Question: Compose a caption that would accompany this figure in a paper.
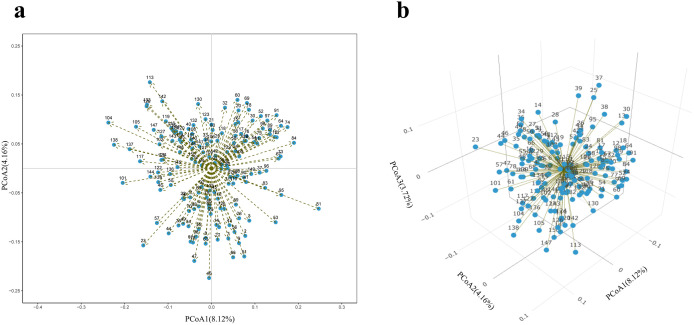
Answer: Principal Component Analysis. (a) Two-dimensional principal coordinate chart. (b) Three-dimensional principal coordinate chart. The first, second, and third principal coordinates explained 8.12%, 4.16%, and 3.72% of the total genetic variation, respectively.